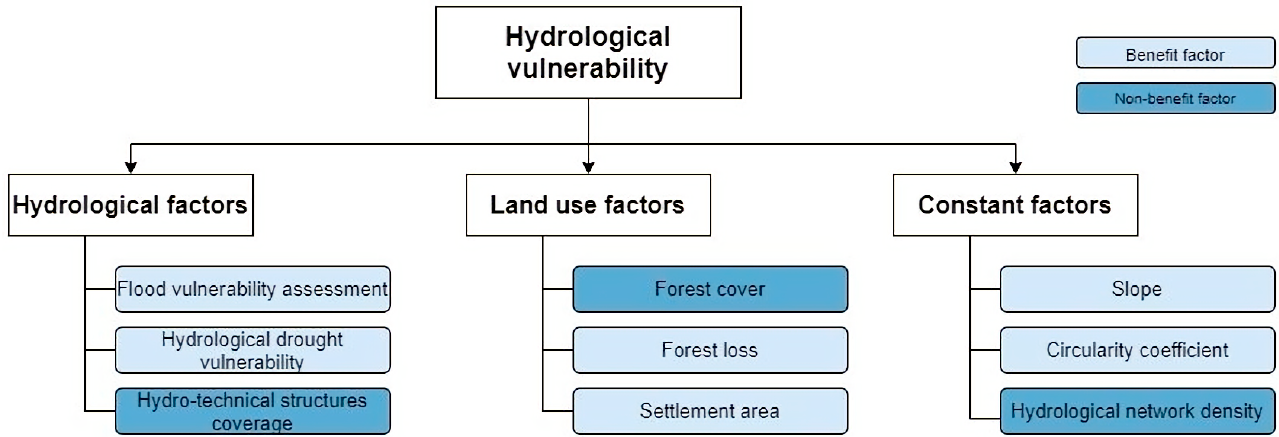
Figure 3. The hydrological, land use, and constant factors. Integration of the relations established between the considered factors is addressed by attributing category level relative importance values. The influence of other factors on the hydrological ones is different for each of the 81 drainage basins. For example, there are catchments where the forest covers are extensive, and influence on the occurrence of floods are significant, but there are catchments with small forest areas, where the influence of this factor is neglectable. The same can be stated for the other land use and constant factors. This explains why the relations between the factors are not key points of the proposed framework and why a weighing MCDM method that does not consider this issue, namely the AHP, is applied instead of a method based on criteria connections, such as the Analytic Network Process (ANP).